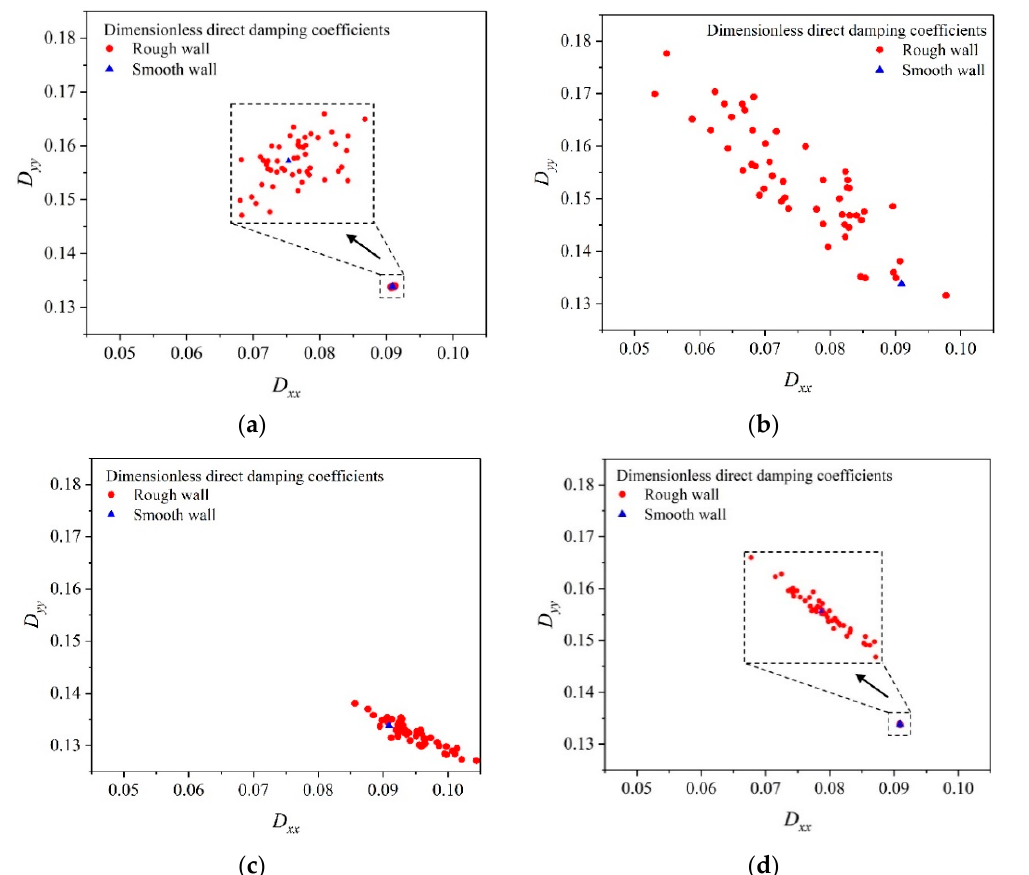
Figure 17. Direct damping coefficients distribution with wear in circumferential regions. ( a ) circumferential region 3. ( b ) circumferential region 4. ( c ) circumferential region 5. ( d ) circumferential region 6.